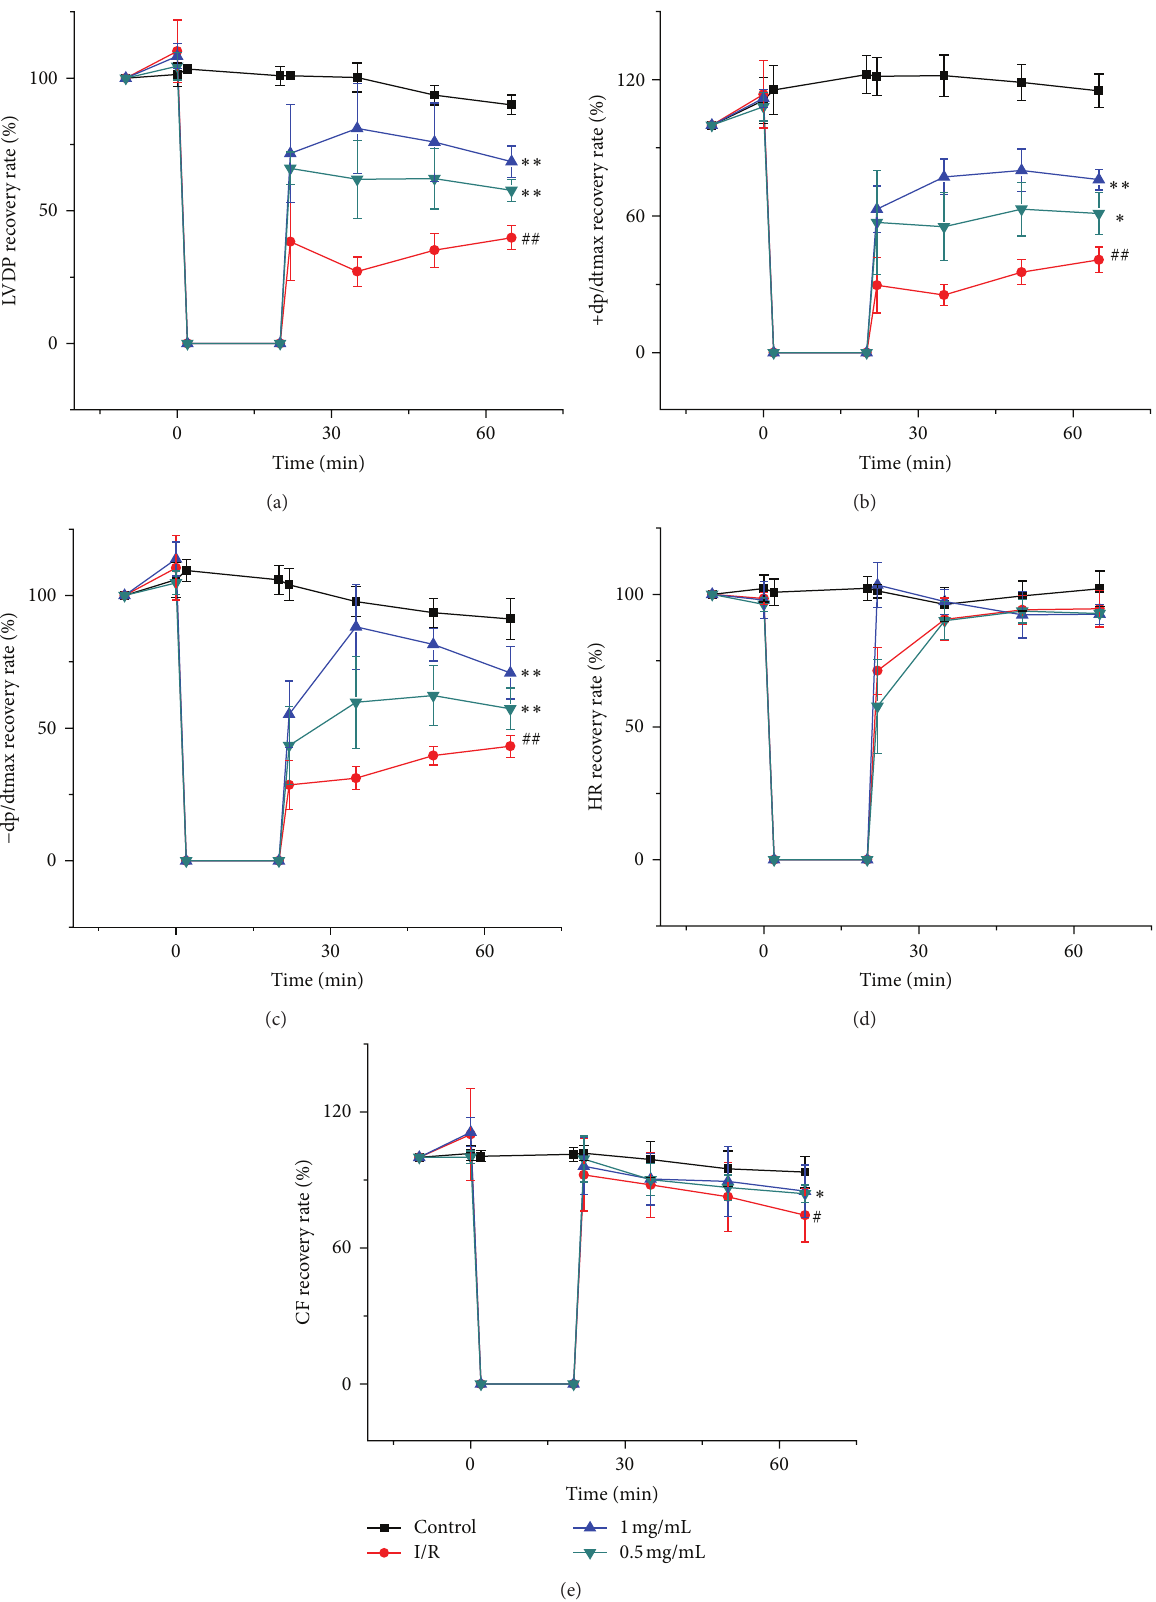
Figure 1: Effects of the aqueous extract of Elaeagnus angustifolia L. leaves upon hemodynamics in a model of ischemia-reperfusion using isolated rat heart. Data are the mean ± SD. Values marked with ## 𝑃 < 0.01 and # 𝑃 < 0.05 are significantly different from control group. Values marked with ∗∗ 𝑃 < 0.01 and ∗ 𝑃 < 0.05 are significantly different from I/R